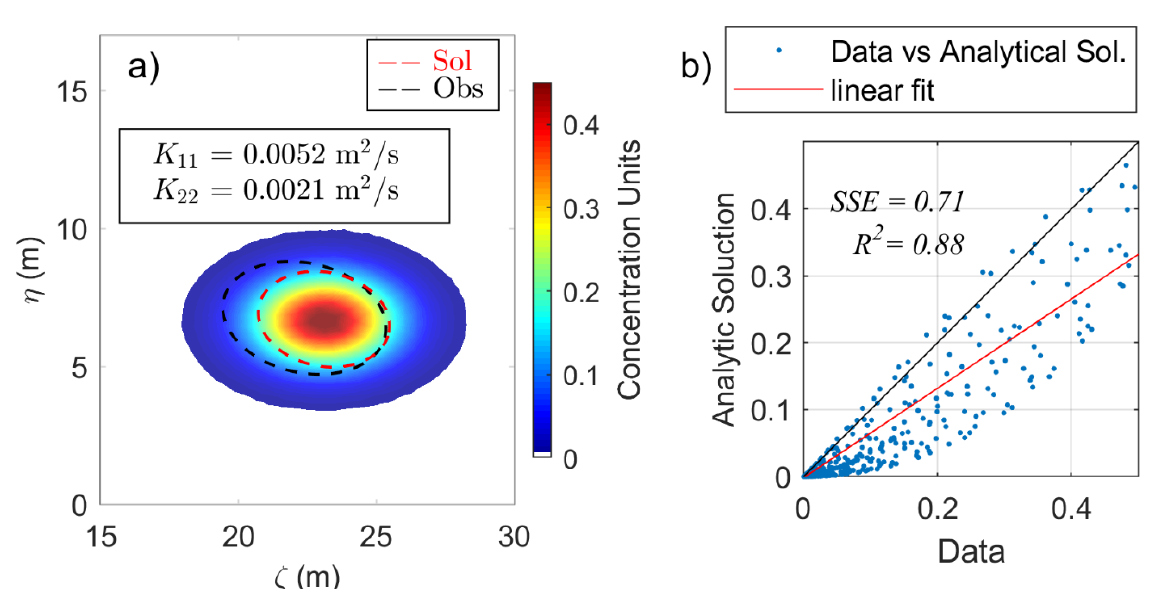
Figure 8. ( a ) Concentration contours obtained with optimal diffusion coefficients for 𝐾 11 = 𝐾 22 . Observations are shown in black and the solution in red. In ( b ), the dispersion diagram of the data and the analytical solution with SSE and 𝑅 2 is shown.